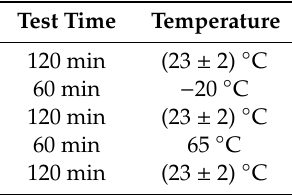
Table 3. Temperature profile during vibration test.